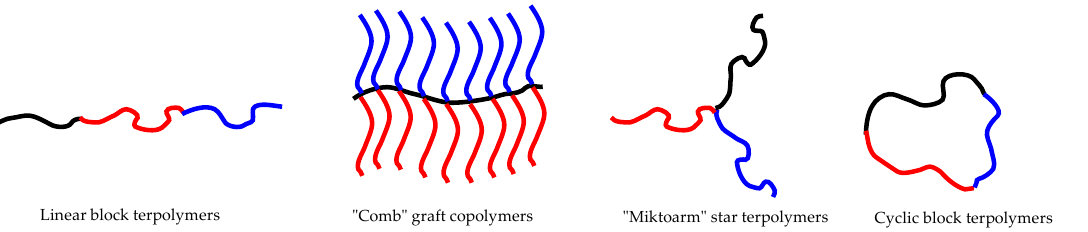
Figure 1. Representative architectures of linear block terpolymers, “comb” graft polymers, miktoarm star terpolymers, and cyclic block terpolymers.